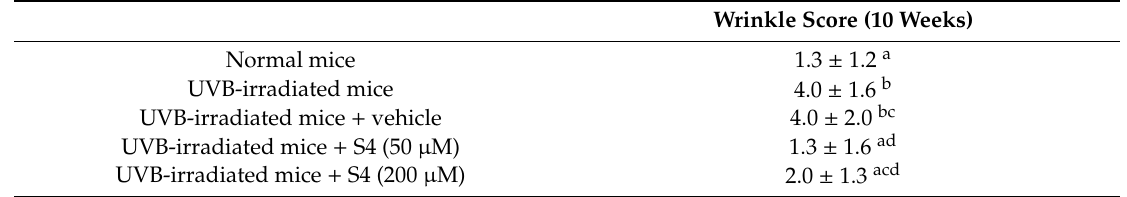
Table 1. Effect of sesamin on skin wrinkles induced by UVB irradiation in hairless mice.